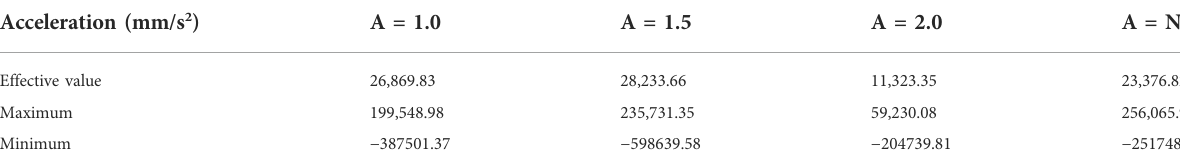
TABLE 5 Acceleration values under different particle shapes.